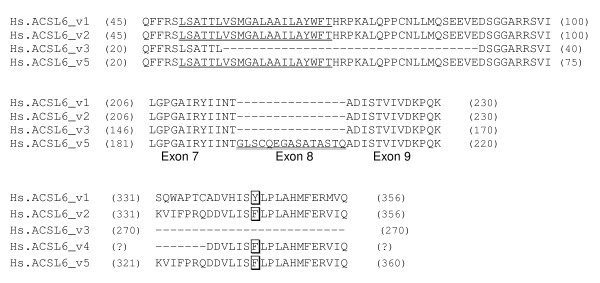
Details of the sequence differences of the five human ACSL6 isoforms. The Y and F residues of the Gate domains are boxed. Position of the first and last residues shown is indicated on the left and right, respectively. Note that only the Gate-domain region of ACSL6_v4 is known. A predicted transmembrane spanning segment at the amino-terminus is shown underlined. The inserted sequence in between Exon 7 and Exon 9 of variant 5, annotated as Exon 8, is shown double-underlined.